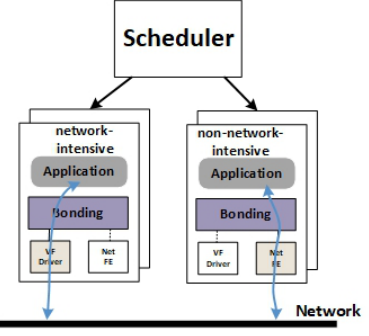
Figure 3. Design according to basic